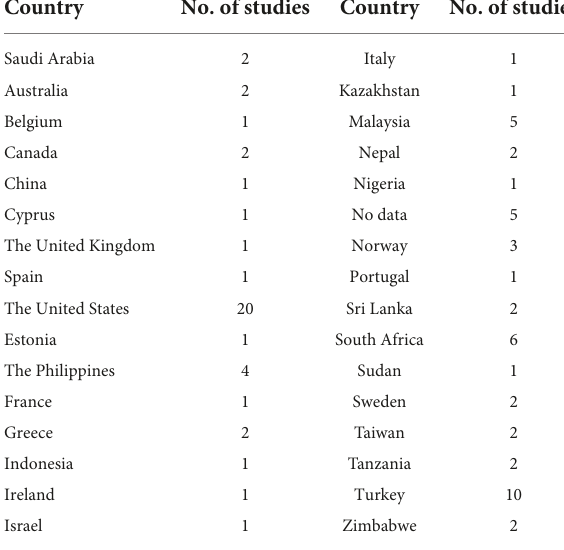
TABLE 3 No. of studies for country.